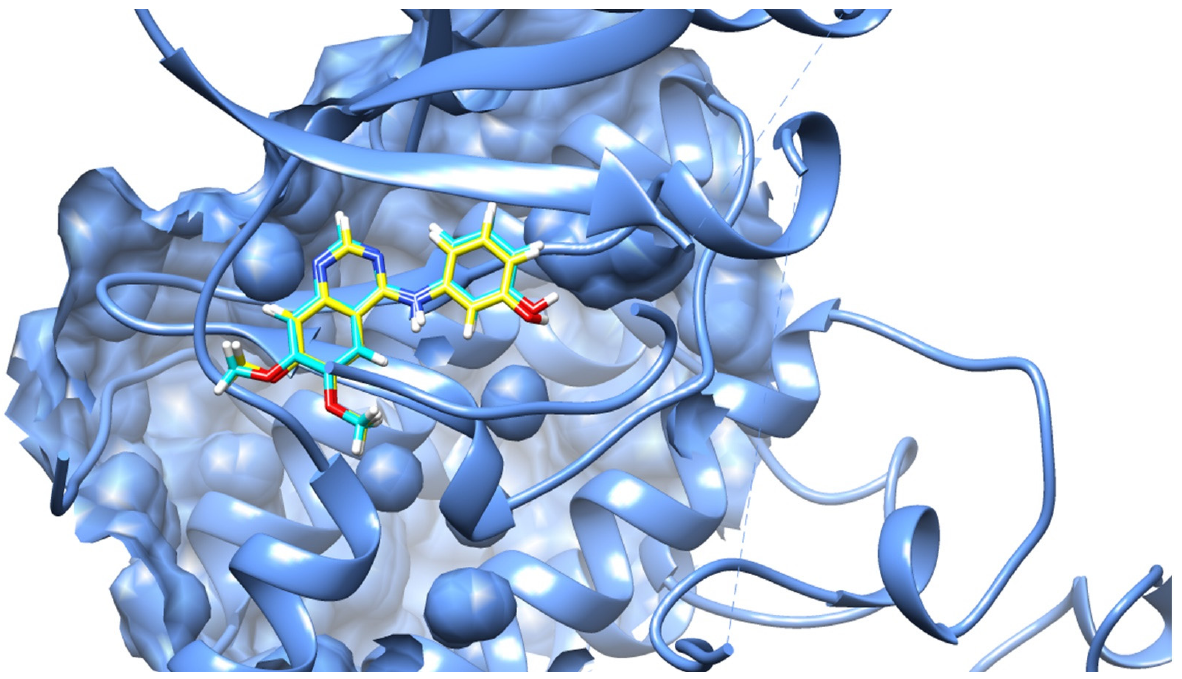
Figure 4. Redocked (yellow) and co-crystallized (baby blue) ligand ( DTQ ) in the ATP binding pocket of CDK2 after self-docking calculations.